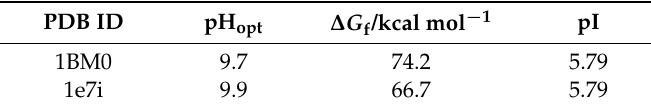
Figure 1. Calculation of HSA’s folding stability and corresponding net charges. ( a ) Calculated free energy of folding ∆ G f as a function of pH for HSA alone (black, PDB ID: 1BM0) [67] and for HSA loaded with seven stearic acids (red, PDB ID: 1e7i) [68]. The black bold letters denote pH ‐ induced dynamic regimes of HSA according to Qiu et al. [53] with conformational isomers in the extended form (E, gray), fast migrating form (F, yellow), norm form (N, green), basic form (B, blue) and an aged form (A, purple). Additionally, the calculated pH of optimum stability (pH opt = 9.80) is shown where ∆ G f is at its minimum. ( b ) Calculated titration curves show the net charge Q = Z · e as a function of pH for HSA alone (black, PDB ID: 1BM0) and for HSA loaded with seven stearic acids (red, PDB ID: 1e7i). The isoelectric points (pI) at Q = 0 can be found at pH 5.79 for both curves (Table 1). All data were generated at 25 ◦ C with PROPKA 3.0 [8,65,66]. The conformational isomers E − A are given as a phase space bar at the top of the graph with the color code given in (a). Table 1. Results from PROPKA 3.0